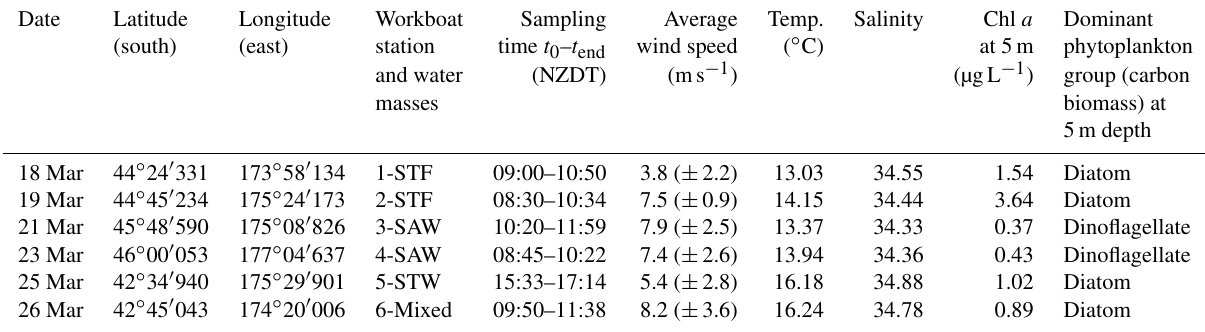
Figure 1. (a) Sea2Cloud voyage track overlain by sea surface temperature ( ◦ C) using Ocean Data View (Schlitzer, 2020), with workboat station positions and water mass type identified. The grey shading shows the seafloor topography, with the darker grey band along 43.5 ◦ S indicating the location of the Chatham Rise. (b) Nitrate concentration during the Sea2Cloud voyage, measured at 5m. Water mass type is indicated by the labels at the top of the figure and separated by the grey vertical dashed lines. Table 1. Summary of environmental conditions during the workboat deployments. Waterside variables were determined from the vessel underway system, which sampled at 5m depth; wind speed was measured by AWS and is presented as the average ( ± standard deviation) over the previous 12h before